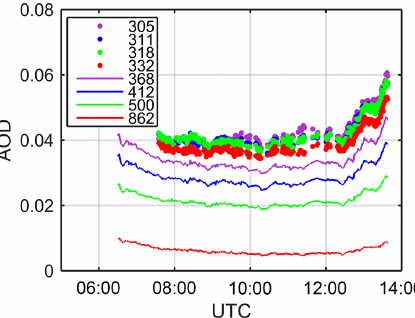
Figure 5. The 1min AOD determined by UVPFR no. 1001 (dots) and PFR-N24 (lines) on the 12 October 2015 in Davos. Data points disturbed by clouds have been